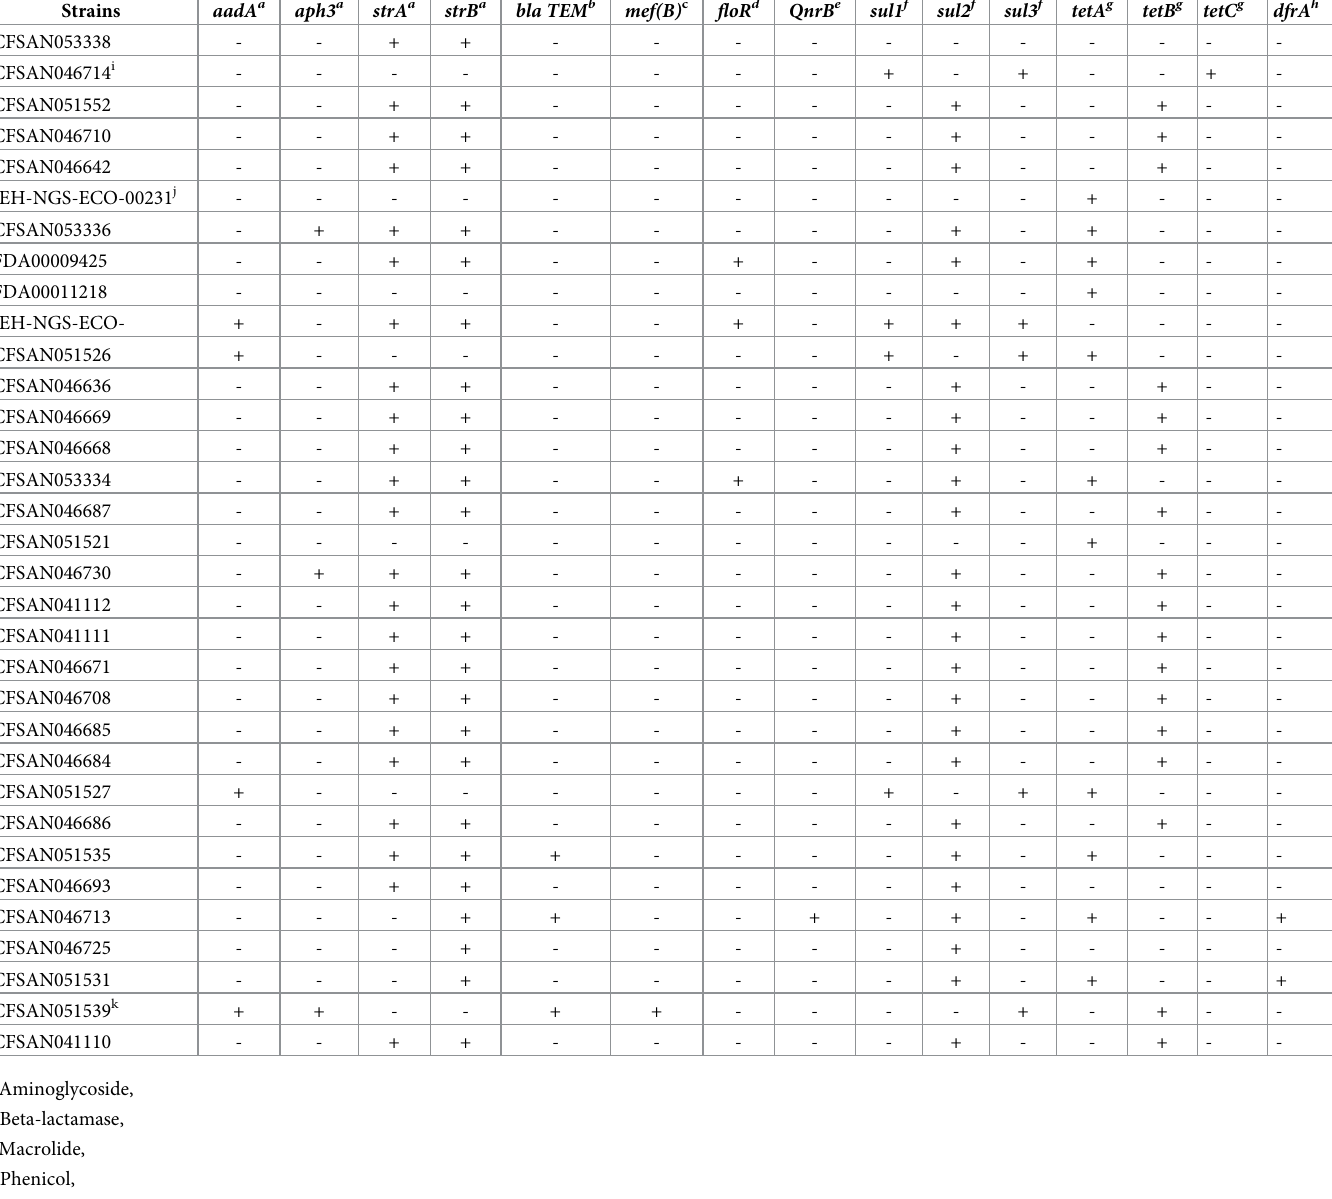
Table 5. Presence of antimicrobial resistance genes identified by in silico analysis in the 276 STEC genomes analyzed in this study.